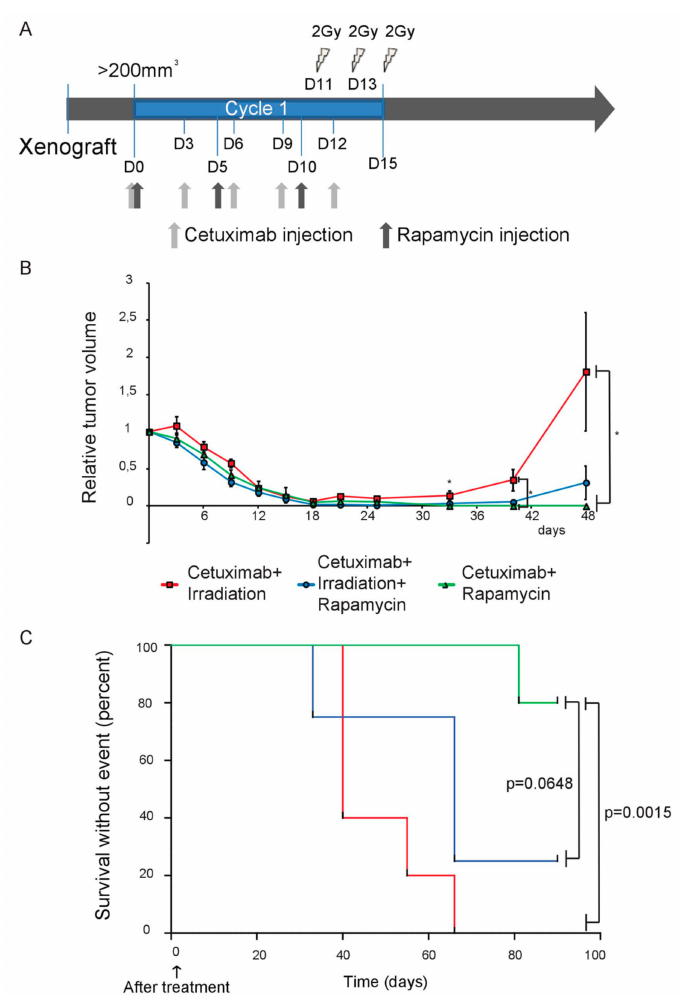
Figure 5. Radiation therapy accelerates tumor relapse of resistant SQ20B xenografts. ( A ) Treatment schedule of nude mice bearing SQ20B xenografts. ( B ) Mean relative tumor volume of SQ20B xenografts measured during and after treatment ( n = 10 tumors per group). Error bars represent the standard deviation in each panel. Statistical significance was evaluated after the completion of the 2 treatment cycles (Kruskal–Wallis test and two-side Mann–Whitney test; * p < 0.05). ( C ) Kaplan–Meier survival curves of mice carrying SQ20B xenografts. A log-rank test analysis showed that mice treated with the cetuximab / rapamycin combination (green curve) displayed a close-to-significantly better survival than mice treated with cetuximab / rapamycin / radiotherapy (blue curve; p = 0.0648), and a significantly better survival than mice treated with cetuximab / radiotherapy (red curve; p =